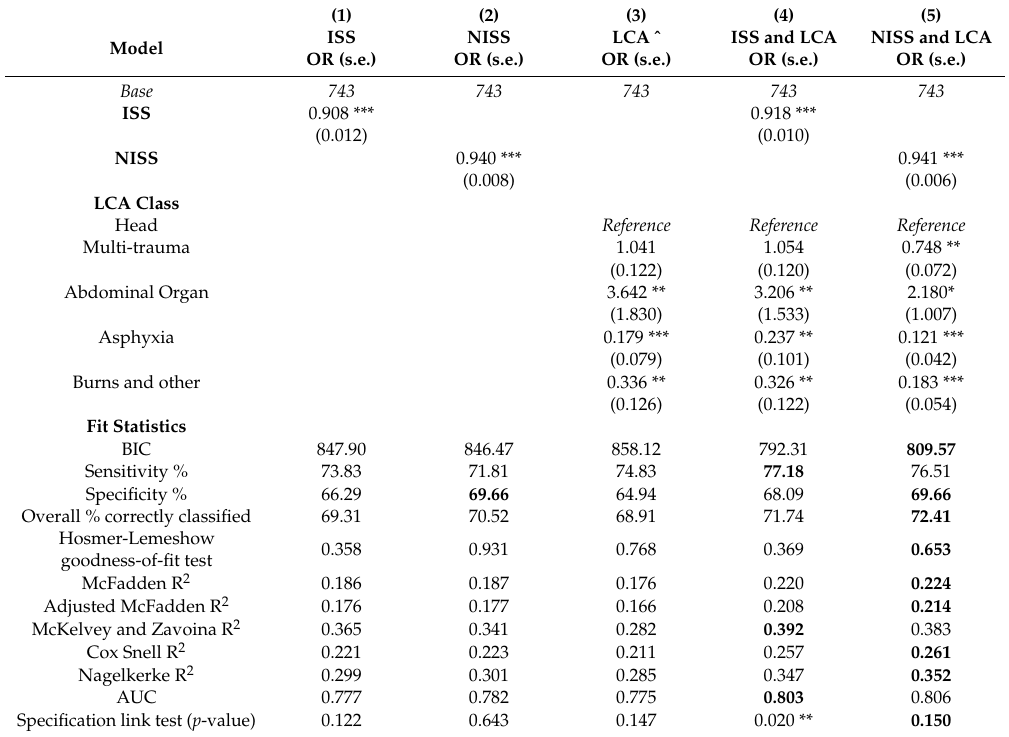
Table 5. Functional outcome logistic regression